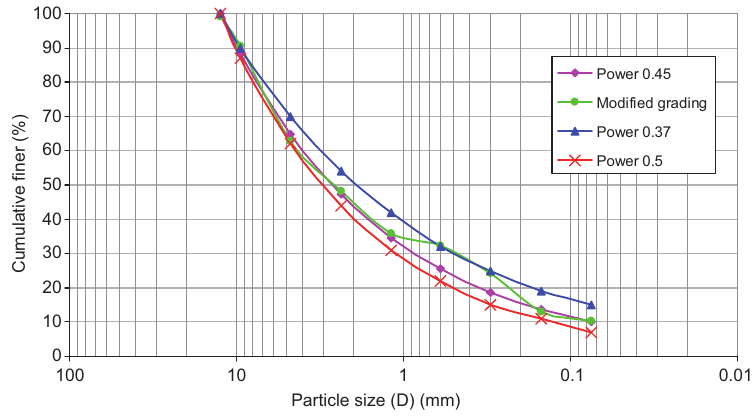
Figure 2 Analysis of actual PSD of aggregates used with other models.